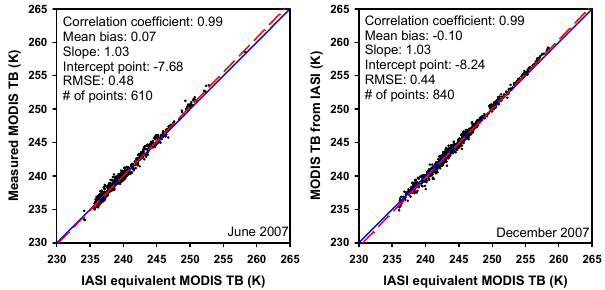
Figure 5: Scatter plots of measured MODIS and IASI equivalent MODIS brightness Fig. 5. Scatter plots of measured MODIS and IASI equivalent temperatures for June 2007 (left) and December 2007 (right) after the spectral shift of the response function by +11cm -1 . MODIS brightness temperatures for June 2007 (left) and Decem- ber 2007 (right) after the spectral shift of the response function by +11cm − 1